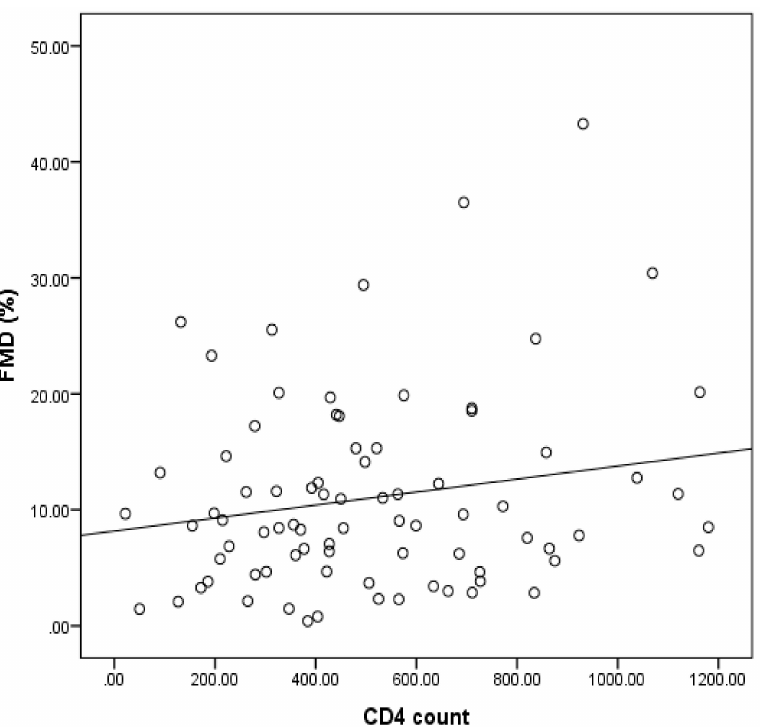
Figure 1. Relationship between FMD (%) and CD4 count on HIV participants on ART. A significant positive correlation ( p < 0.05) between FMD (%) and CD4 count was observed in HIV participants on